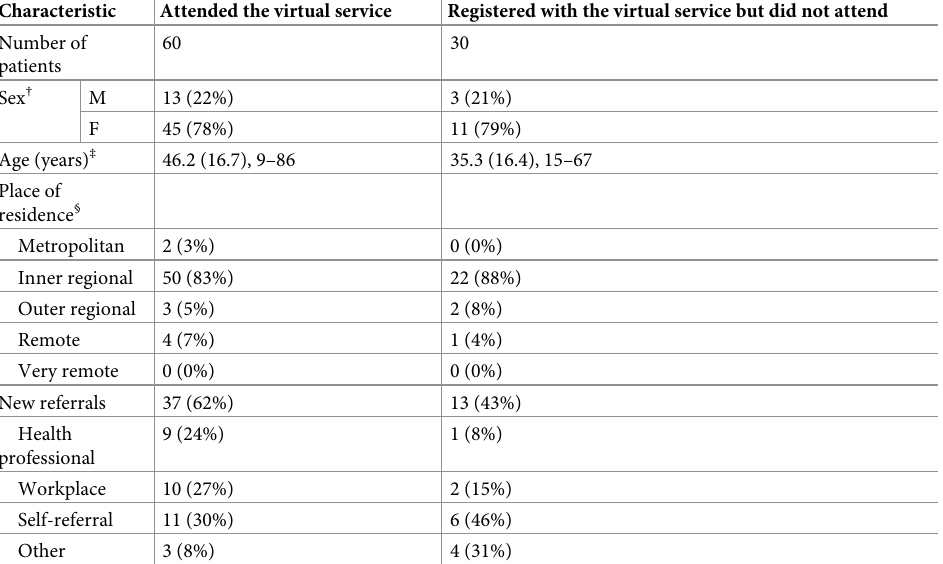
Table 1. Characteristics of patients who accessed the virtual service between 25 March 2020 and 30 September 2020. Data reported as n (%); or mean (SD), range.